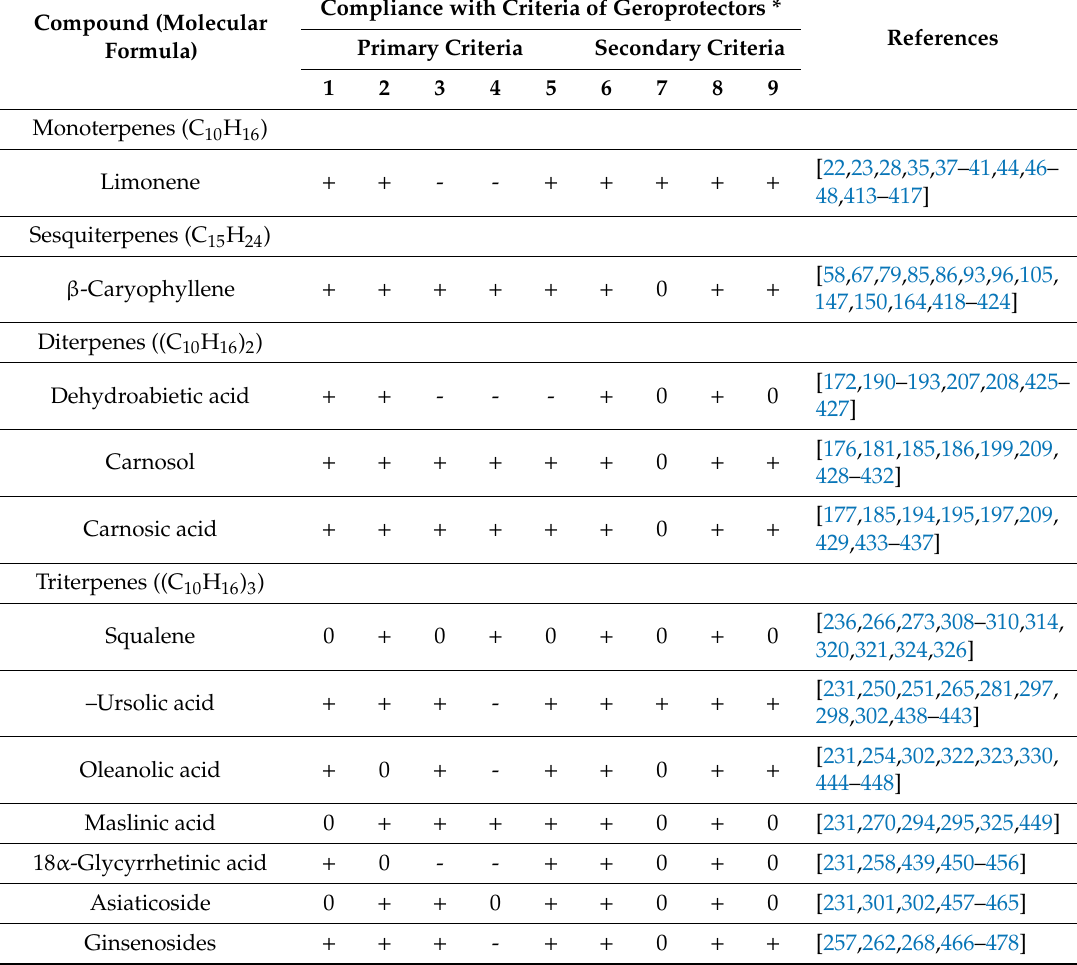
Table 1. Geroprotective potential of some terpenes and